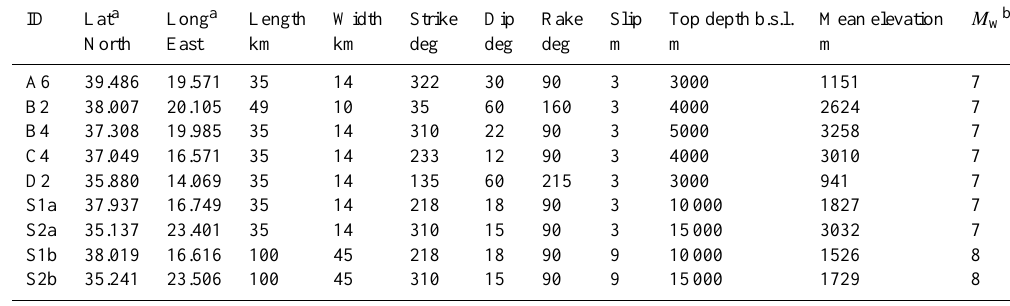
Table 6. Parameters of sample fault ruptures (see Fig. 6a) for locations. ID Lat a Long a Length Width Strike Dip Rake Slip Top depth b.s.l. Mean elevation M wb North East km km deg deg